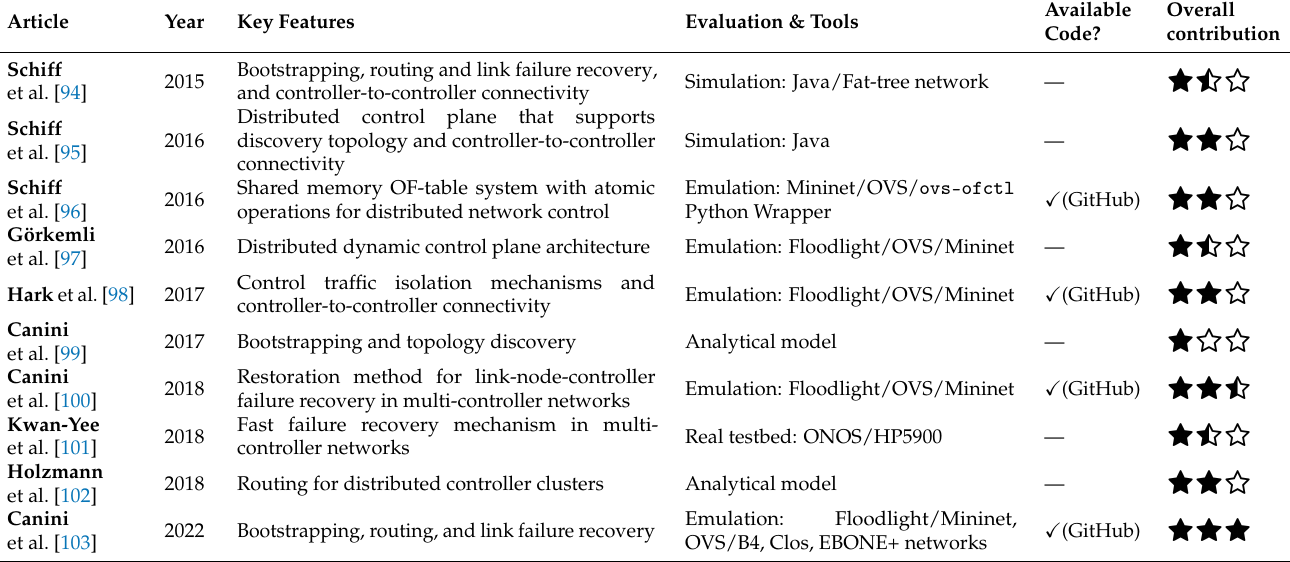
Table 5. Summary table of in-band proposals that support distributed